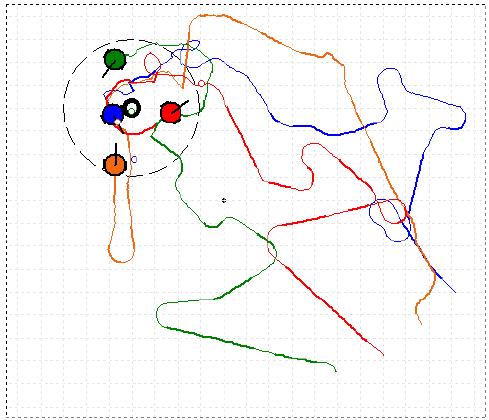
Figure 13. One of recorded CPT processes in the natural airflow field of Arena I using the SS algorithm (four robots were